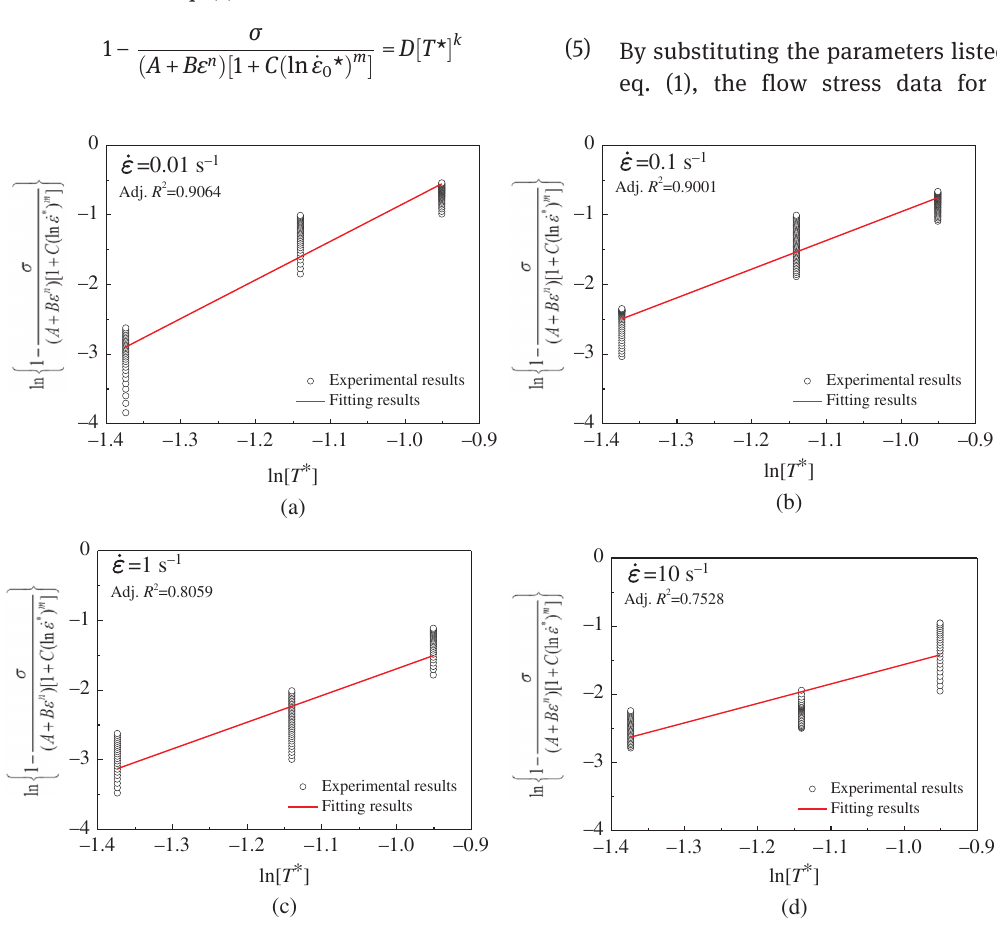
Figure 8: The relationships between ln 1 − σ (c) _ ε =1s − 1 , (d) _ ε =10s − 1